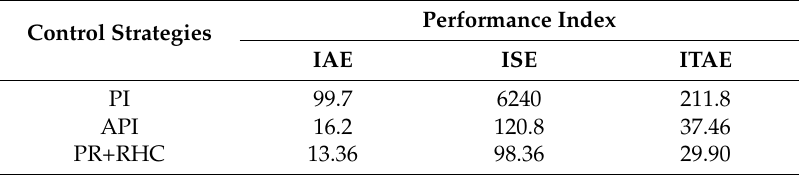
Table 6. Performance evaluation of the designed control strategies for I d .